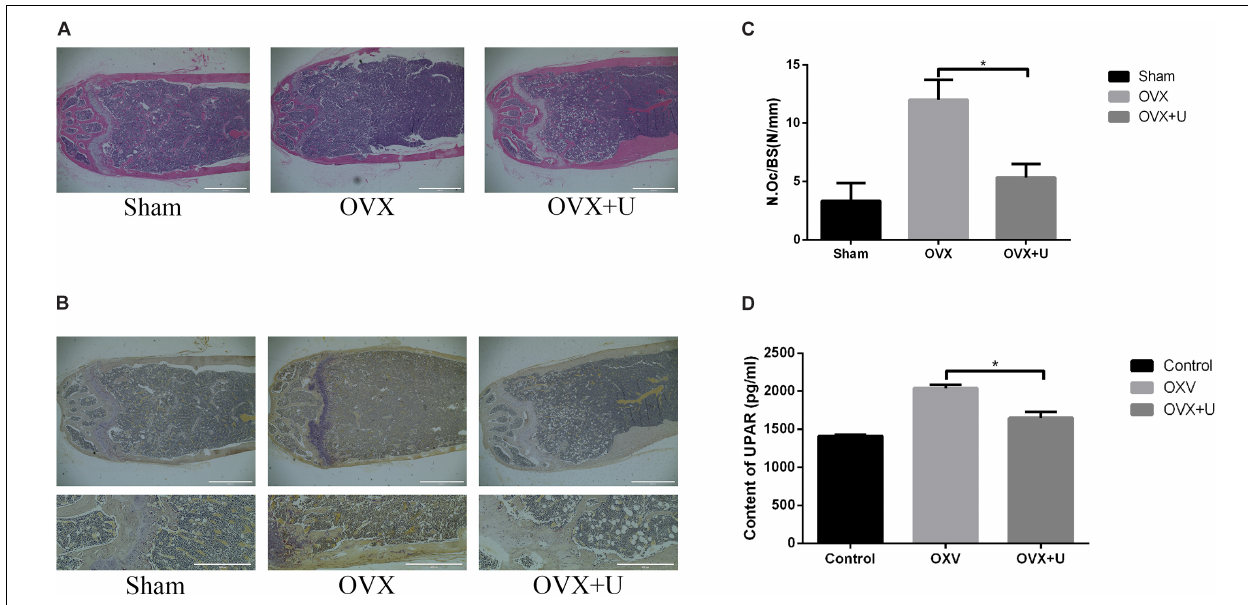
FIGURE 2 | Ulinastatin inhibits the formation of osteoclasts and bone loss in OVX mice, meanwhile decreases the serum level of uPAR. (A) Distal femurs were embedded with paraffin and sliced up, then H&E and TRAP staining were performed. (B,C) Distal femurs were embedded with paraffin and sliced up, then TRAP staining were performed. The osteoclast number/bone surface (N.Oc/BS, N/mm) was quantified. Data are represented as mean ± SD. n = 10 and ∗ P < 0.05. (D) The serum level of uPAR was detected by ELISA. Data are presented as mean ± SD. n = 10 and ∗ P <